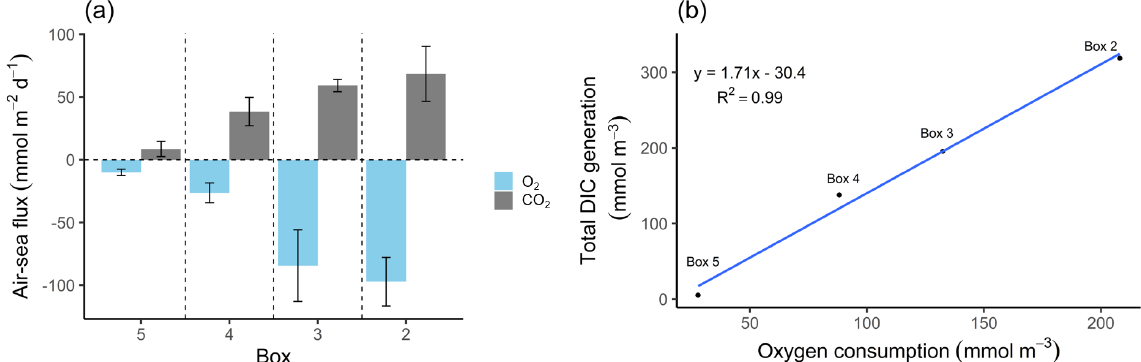
Figure 4. O 2 and CO 2 characteristics. (a) Air–sea fluxes (ASFs) of oxygen (O 2 ) and carbon dioxide (CO 2 ) per box. The O 2 ASFs were calculated from p O 2 and observed oxygen concentrations, and the CO 2 ASFs were calculated from p CO 2 values and observed TA (Table 2). Values are shown with standard deviation represented as spatial variability (error bars). Positive values indicate outgassing, while negative values indicate a gas uptake into the water. The Hamburg port area is located in box 2 and the lower estuary in box 5. (b) Relationship between metabolic DIC generation and O 2 consumption along the estuary in concentration (mmolm − 3 ) . Please note the different parameters in the panels. Table 2. Average calculated gas values per box. O 2 concentration is the observed oxygen. O 2 consumption is the amount of oxygen consumed (i.e., AOU + oxygen uptake). Metabolic DIC gen. is the generated DIC. O 2 ASF is the oxygen, and CO 2 ASF is the carbon dioxide air–sea flux along the surface. Positive flux values indicate outgassing, while negative values indicate an absorption into the water. p CO 2 is the partial pressure of carbon dioxide and corresponds to the CO 2 concentration in the water. The standard deviation ± SD as spatial variability is given when possible. An uncertainty estimation including the uncertainties of the analytical measurements, the air–sea flux estimation, and the river discharge is given as ( ± absolute errors) by an error propagation (Methods).